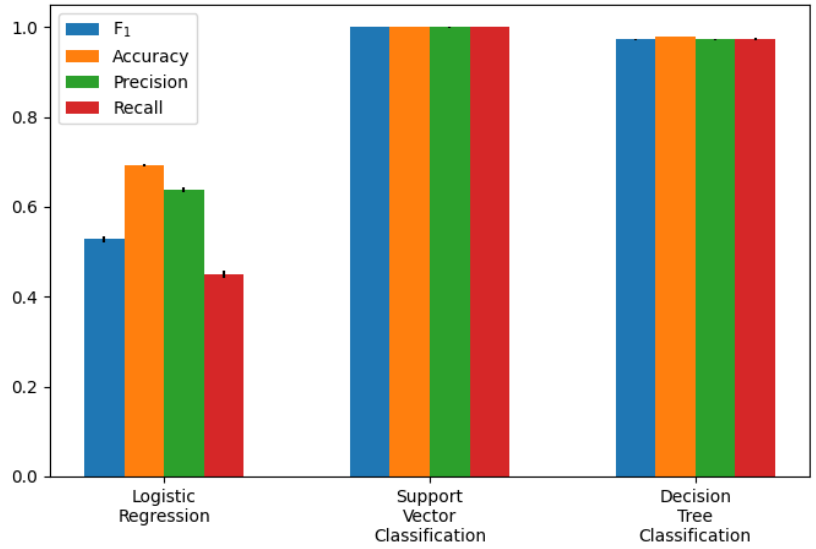
Figure 10. Classification model performance as bar chart (exact values are in Table